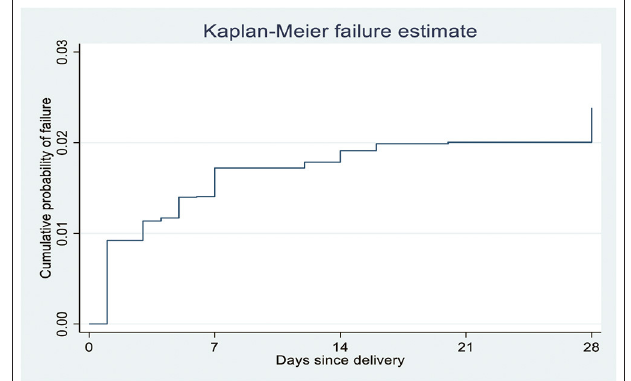
FIGURE 2 | Kaplan-Meier failure estimates of neonatal mortality per day since delivery in Ethiopia, 2020 ( n = 2481).